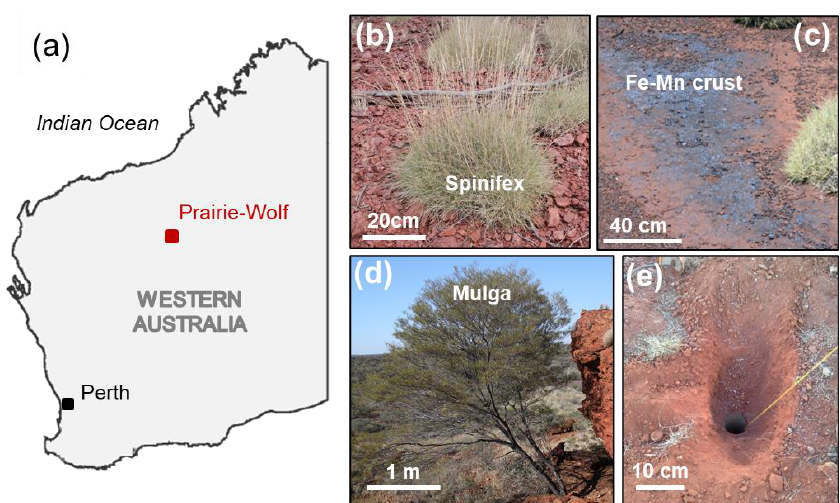
Figure 1. Study area and sample material overview. ( a ) Location of study area in Western Australia. ( b ) Photograph of a Triodia basedowii (spinifex) plant. ( c ) Photograph of Fe – Mn crust. ( d ) Photograph of Acacia aneura (mulga) plant. ( e ) Photograph of a water bore.